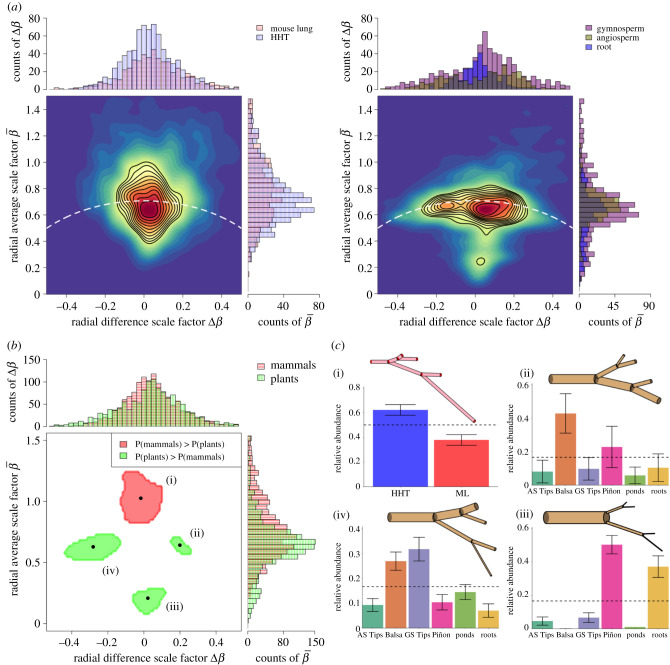
Classification based on features (the radial scale factors β¯ and Δβ) that are related to fluid transport—blood or sap—via volume-flow rate and hydraulic resistance through networks and vessels. (a) Joint and marginalized distributions for the mammal (left) and plant (right) radius scale factors using the KDE method. Mammals are divided into mouse lung and HHT, and plants are divided into the groups of gymnosperms (GS), angiosperms (AS) and roots. Black contours represent lines of constant probability density, ranging from 0.5 to 0.05 in steps of 0.05. White dashed lines are graphs of the radius conservation equation for area-preservation. (b) Regions of significantly (p < 0.05) greater joint probability density for the mammals (red) or plants (green). (c) Representative diagrams of tree networks and bar plots of relative abundances of each group/species are presented for each region of significant classification in (b) (clockwise). Scale factor values for tree networks are determined by geometrically averaging over all classified data points within each significance region. Means and standard deviations for bar plots are determined by bootstrapping the KDE method 1000 times. Horizontal black dashed lines represent null expectations of relative abundances. These significance-region abundances are corroborated with global-level testing of all pairs of branching networks (see electronic supplementary material, table S1). The global-level test is a method that effectively integrates over the entire feature space to produce one singular p-value for the comparison [33].